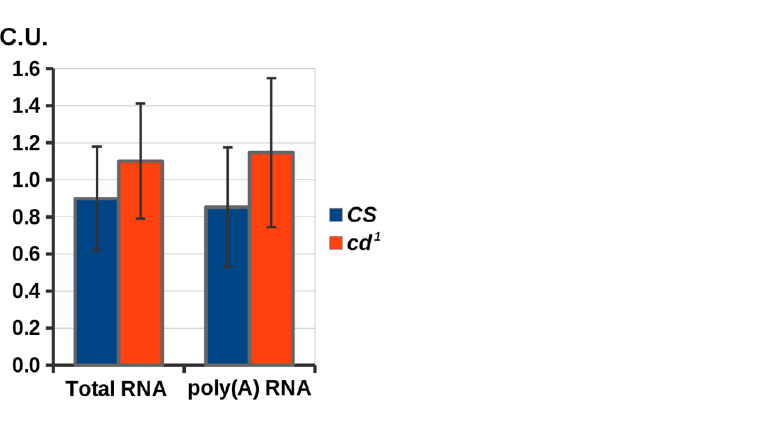
Figure 5. RT-PCR analysis of cd expression in CS and cd 1 late pupae. Y axis: expression level (in conventional units). Standard error is shown. No statistical differences were observed (two-sided t -test; p < 0.05, n = 3).